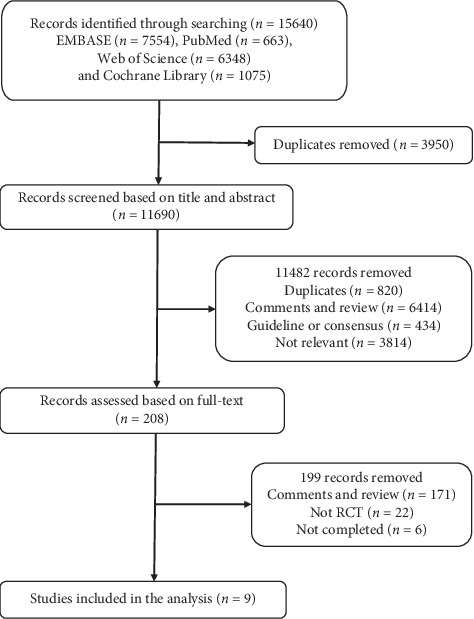
Flow diagram of the clinical trial selection process.